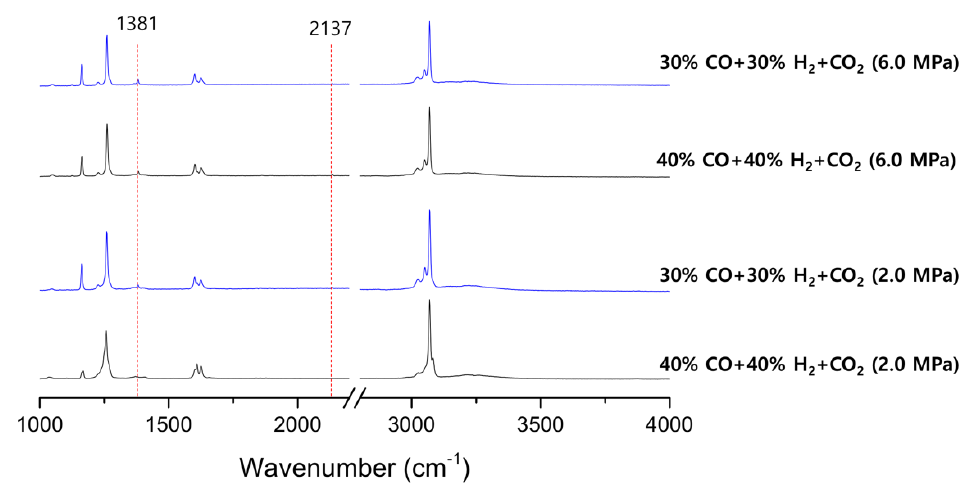
Figure 3. Raman spectra for hydroquinone (HQ) samples after reaction with ternary (CO 2 + CO + H 2 ) gas mixtures at 2.0 and 6.0 MPa. Blue plots represent HQ samples after reaction with the ternary (30% CO + 30% H 2 + 40% CO 2 ) gas, while black ones represent HQ samples after reaction with the ternary (40% CO + 40% H 2 + 20% CO 2 ) gas. Dashed lines at 2137 cm − 1 and 1381 cm − 1 indicate the stretching mode for C–O bonds of CO and CO 2 molecules trapped in the clathrate cages, respectively.